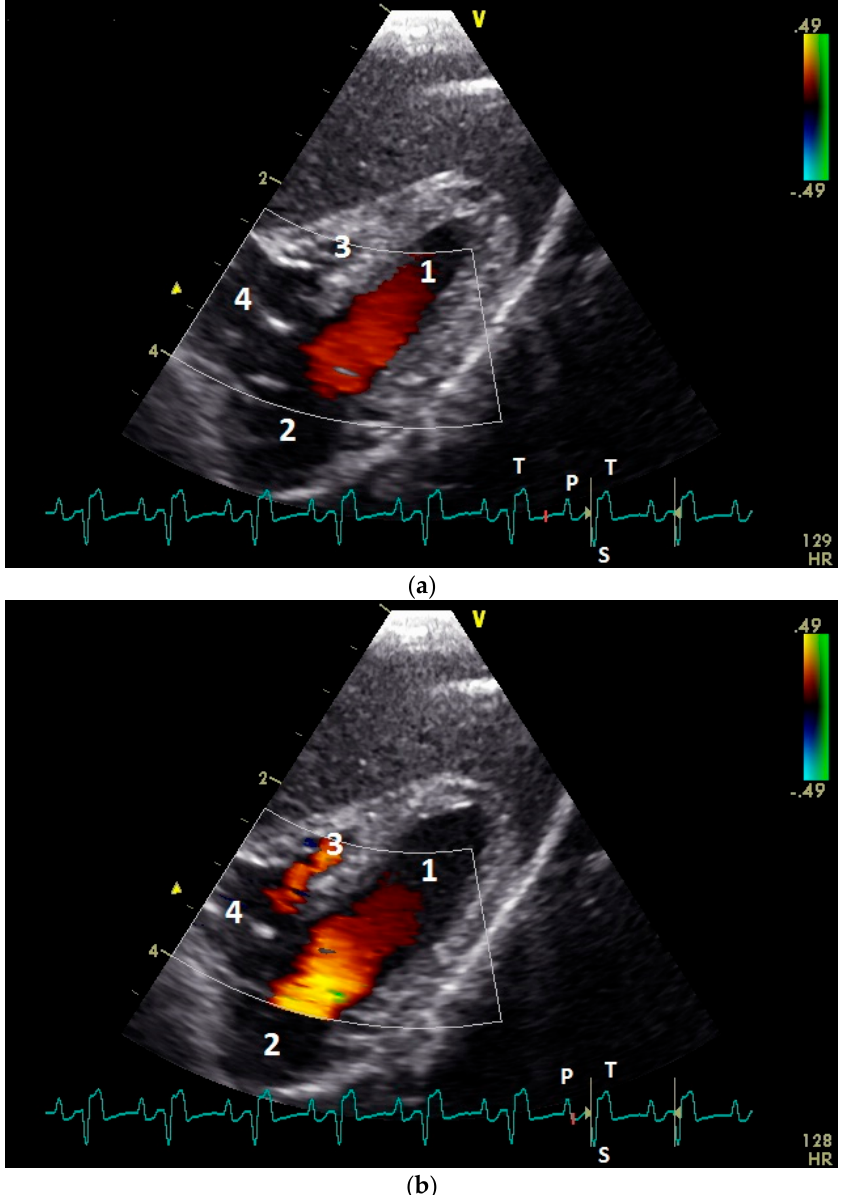
Figure 3. Color Doppler echocardiographic image of the early passive ventricular filling blood flow ( a ) and the late active ventricular blood inflow ( b ) of a conscious healthy racing pigeon using the right parasternal approach. 1: left ventricle; 2: left atrium; 3: right ventricle; and 4: right atrium. The red color visualizes the atrioventricular blood flow. Electrocardiogram: P: P wave; S: S wave; and T: T wave.